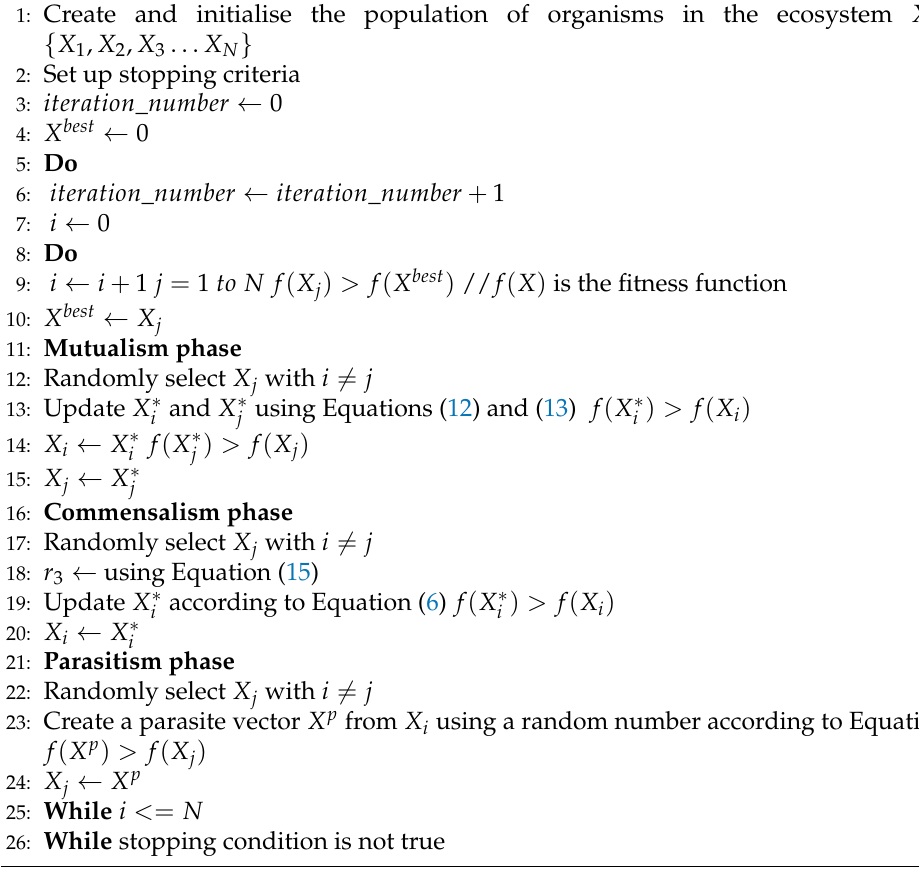
Algorithm 3 Enhanced Discrete Symbiotic Organism Search